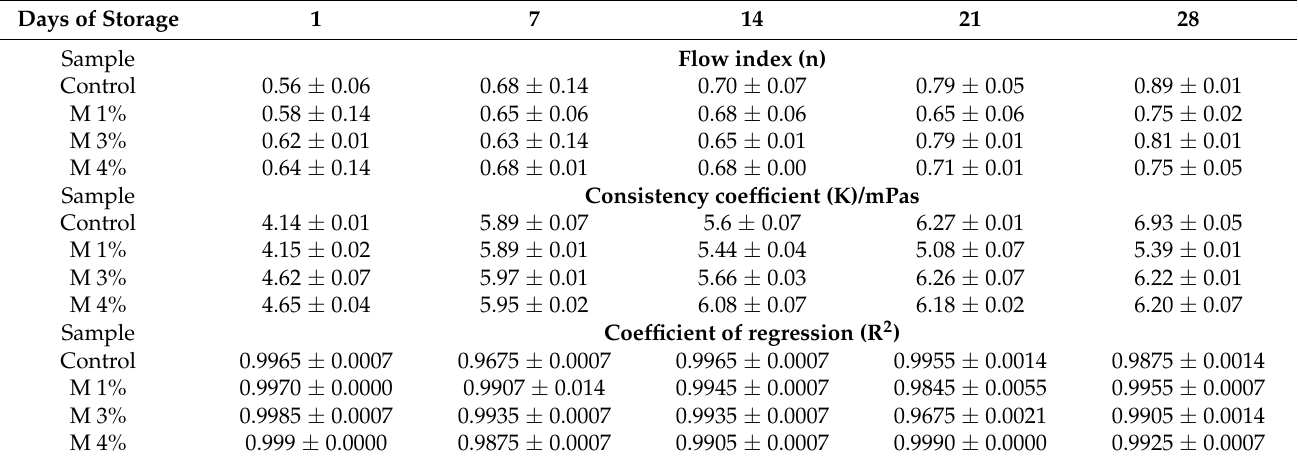
Table 7. Parameters of rheological behaviour (flow index (n); consistency coefficient K (mPas); coefficient of regression (R 2 ) according to Ostwald–de Waele model in the control sample (Control) and samples with moringa extract addition (1, 3 and 4% of extract addition, M 1%, M 3%, M 4%) during 28 days of cold